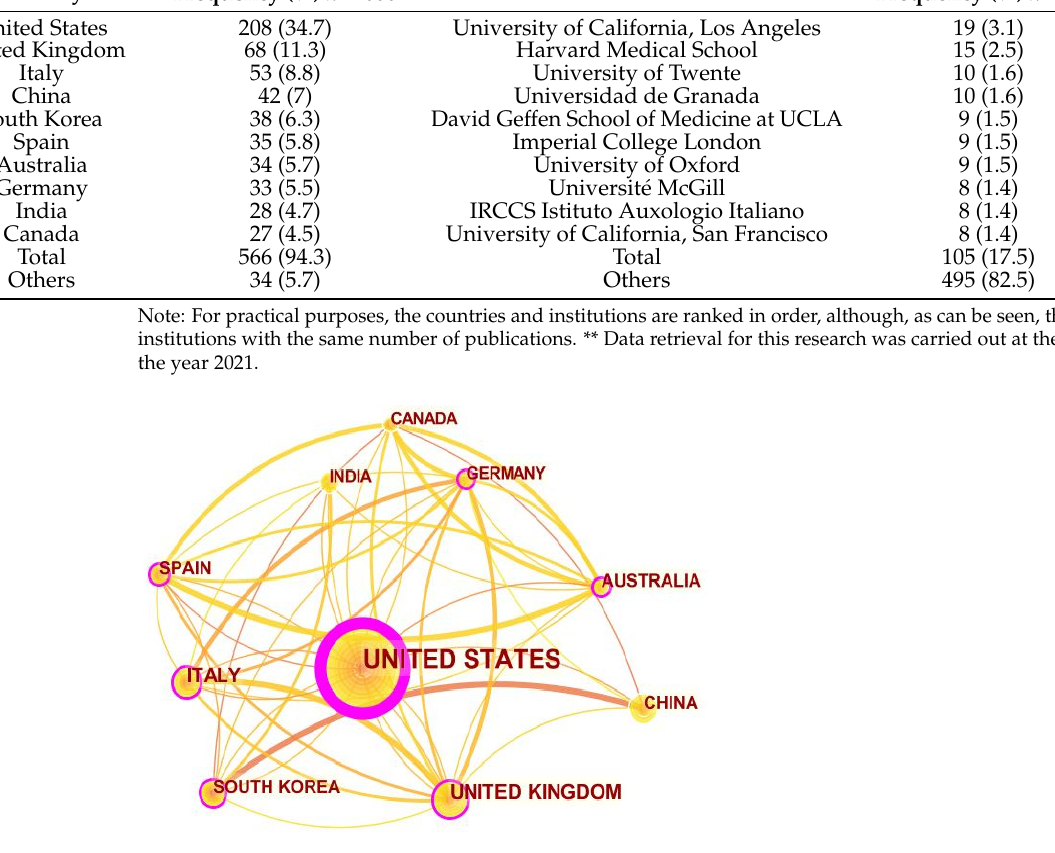
Figure 4. Distribution by country. Larger size and depth of color indicate a greater number of publications and the lines represent their collaboration.